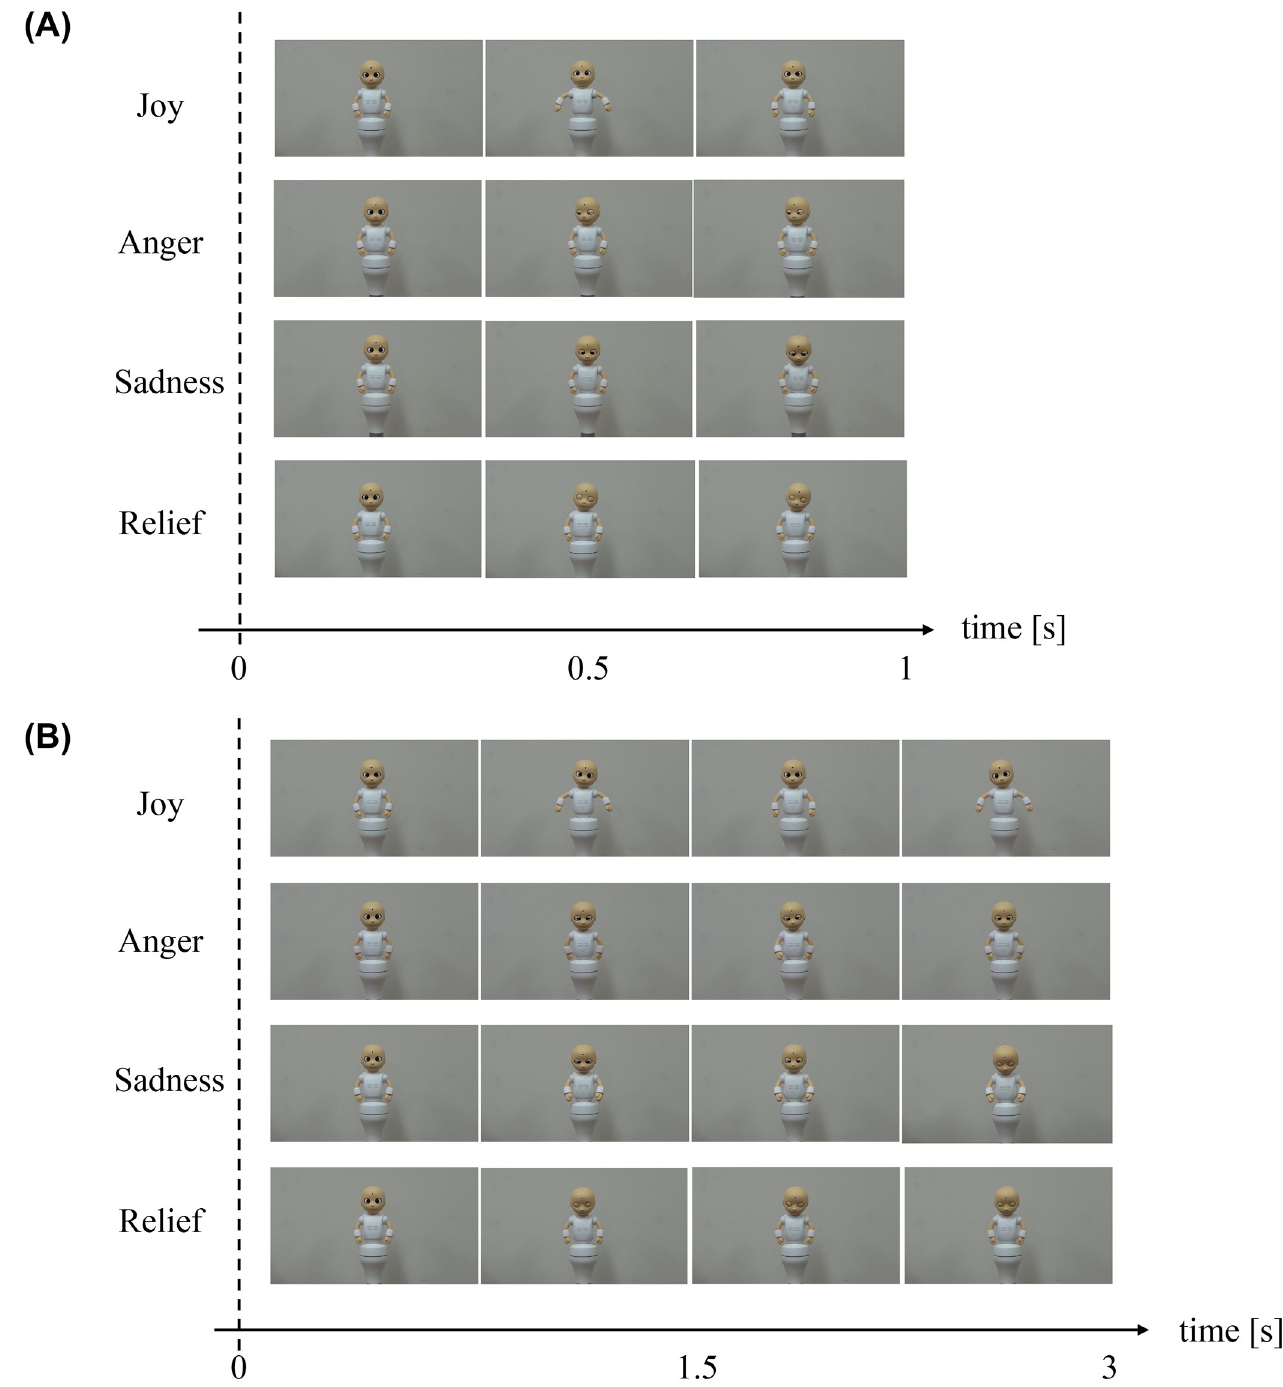
Fig 4. Robot’s gesture for emotion expression. Gestures elected for emotion expression of the robot for (A) short-term expressions, and (B) long-term emotions. The mentioned times in the time axis are the approximate ones and varies depends on the design of each gesture. independent variable of the experiment, three types of oscillations were utilized, that is, no- oscillation, slow oscillation, and fast oscillation because the other oscillations (very fast, medium, and very slow oscillation, see Fig 2B for detail) did not match the short-term gestures